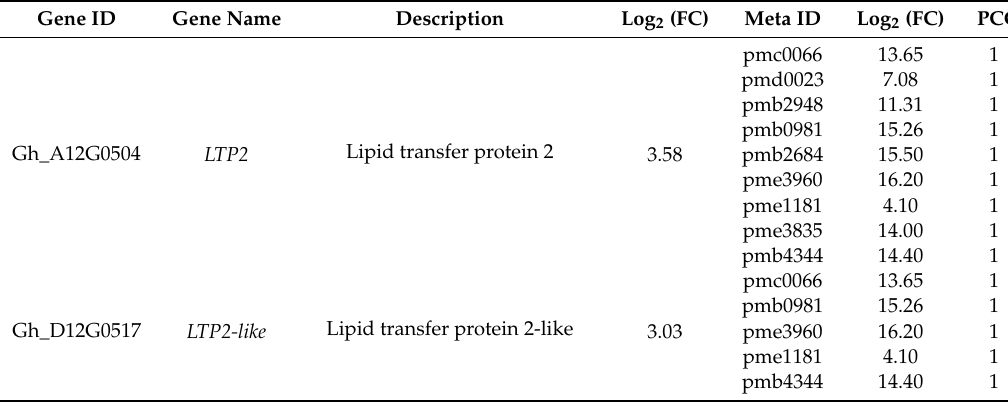
Table 6. Classic gene-metabolite pairs involved in flavonoid biosynthesis during somatic embryo development (GE vs. PEC).